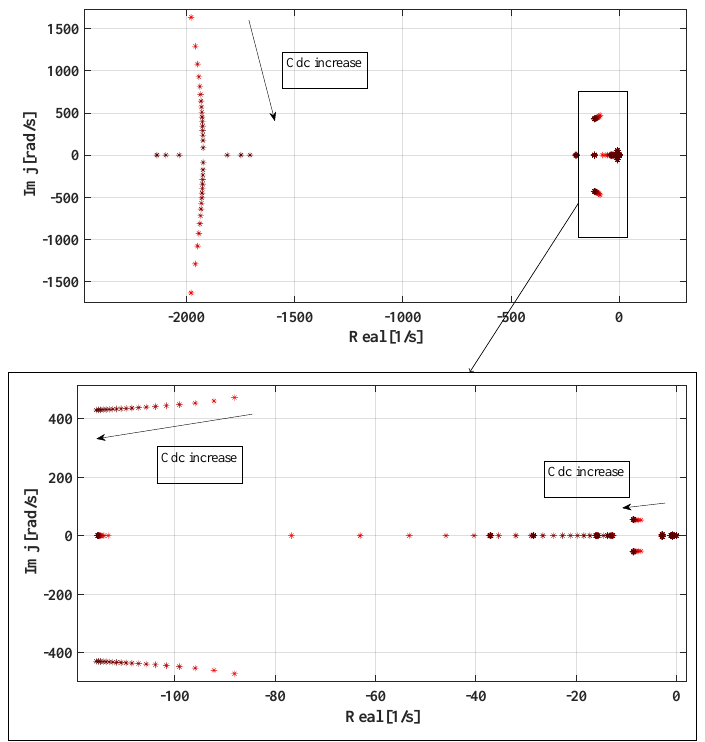
Figure 6. Eigenvalues with varying Capacitance